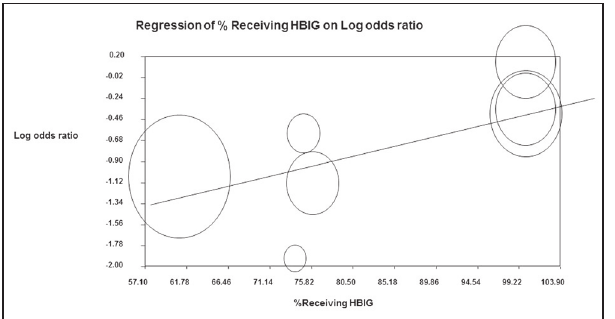
Figure 4) Adjusted meta-regression of percent of women receiving